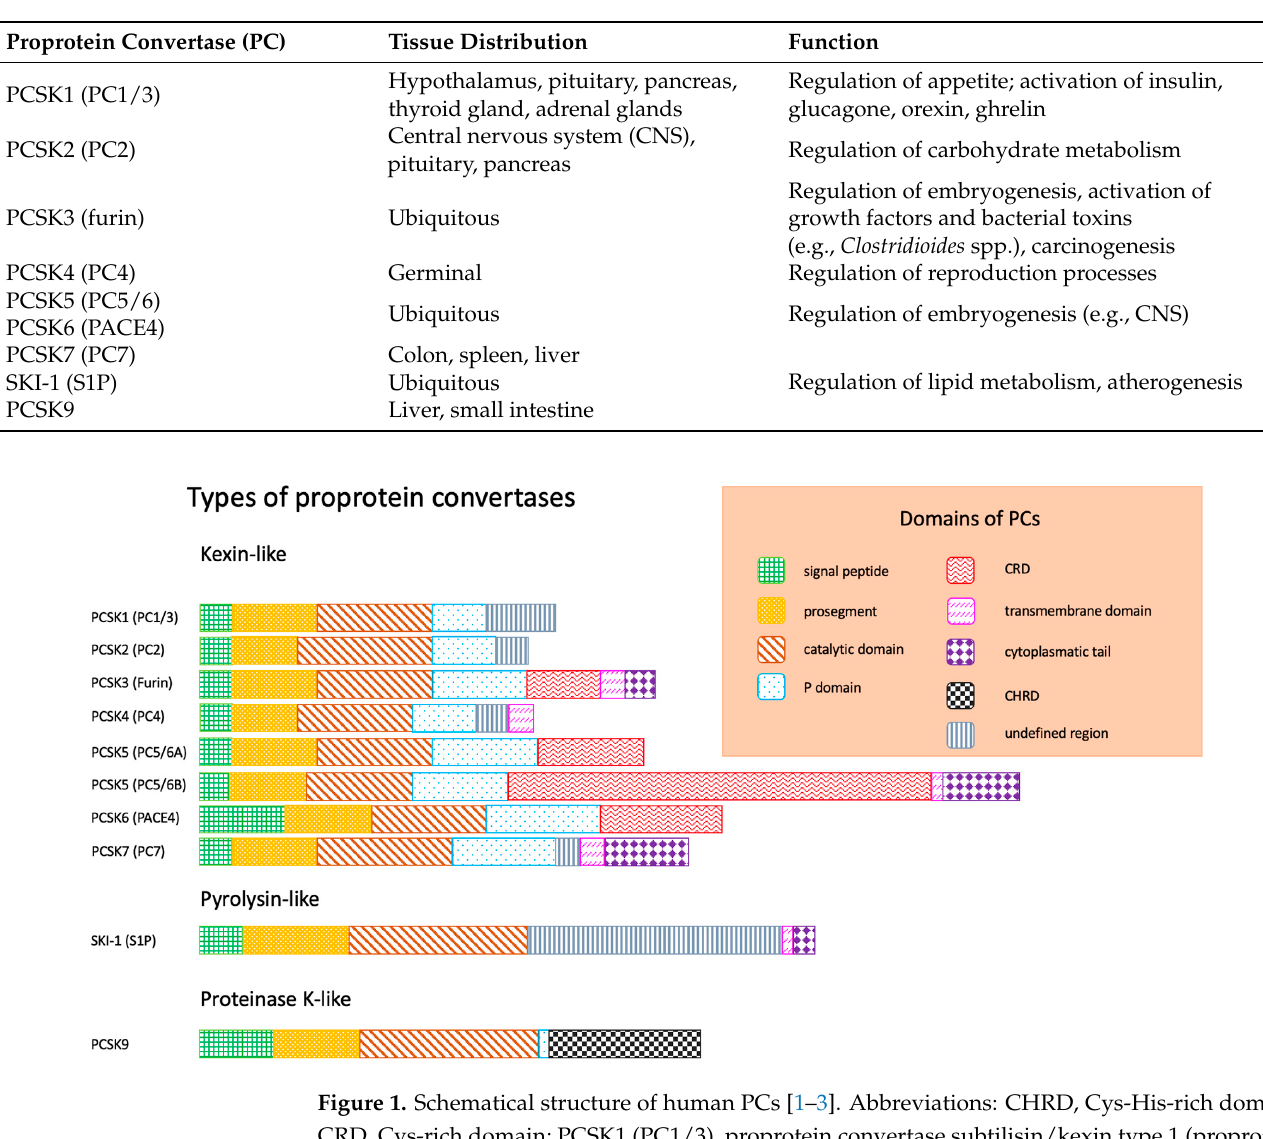
Table 1. Basic functions and tissue distribution of proprotein convertases (PCs) [1–3].